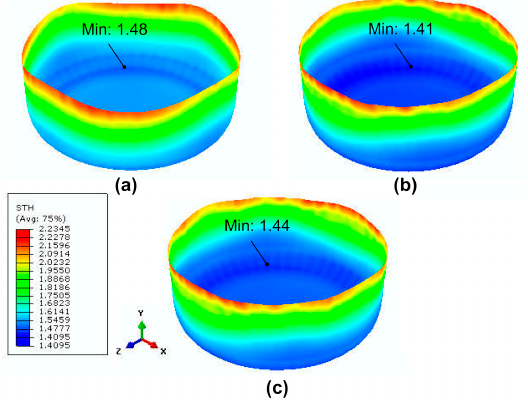
Figure 16. Sheet thickness distribution of the deep-drawn cup of AA1050-O with ( a ) uniform BHF and optimal varying BHFs obtained by ( b ) analytical model and ( c ) DNN-GA model.